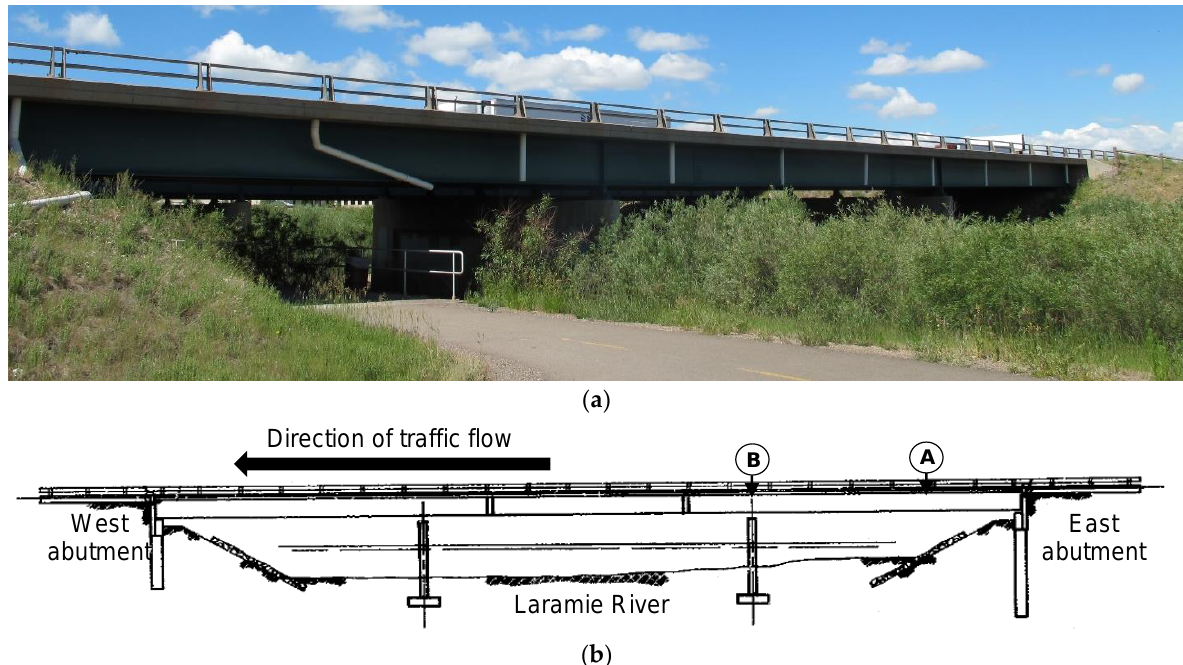
Figure 3. Bridge with web-and-flange array: ( a ) westbound structure; ( b ) elevation drawing. Table 1. Nominal section dimensions, mm (in.), at selected locations of bridge with web-and-flange sensor array.